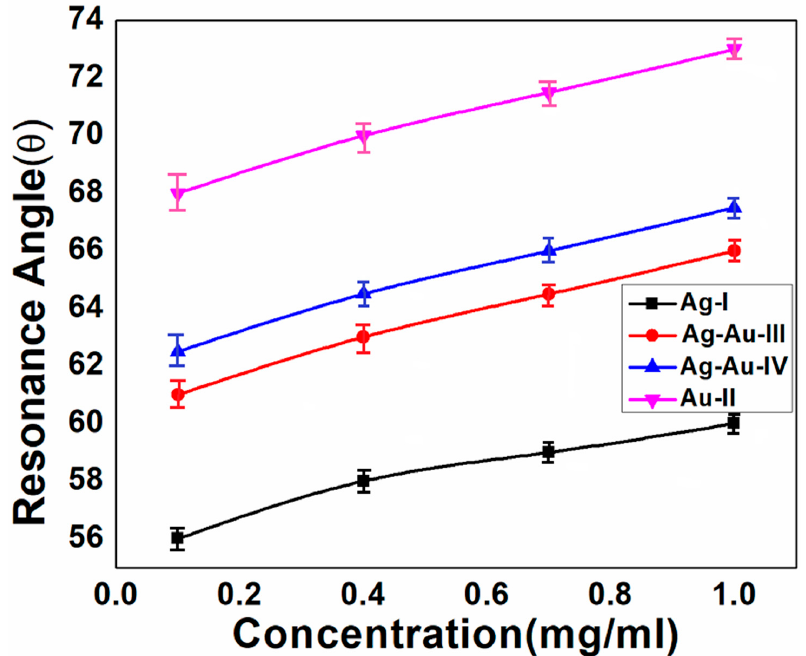
Figure 8. Graph of resonance angle with concentration of antibody protein exposed to sensor surface.